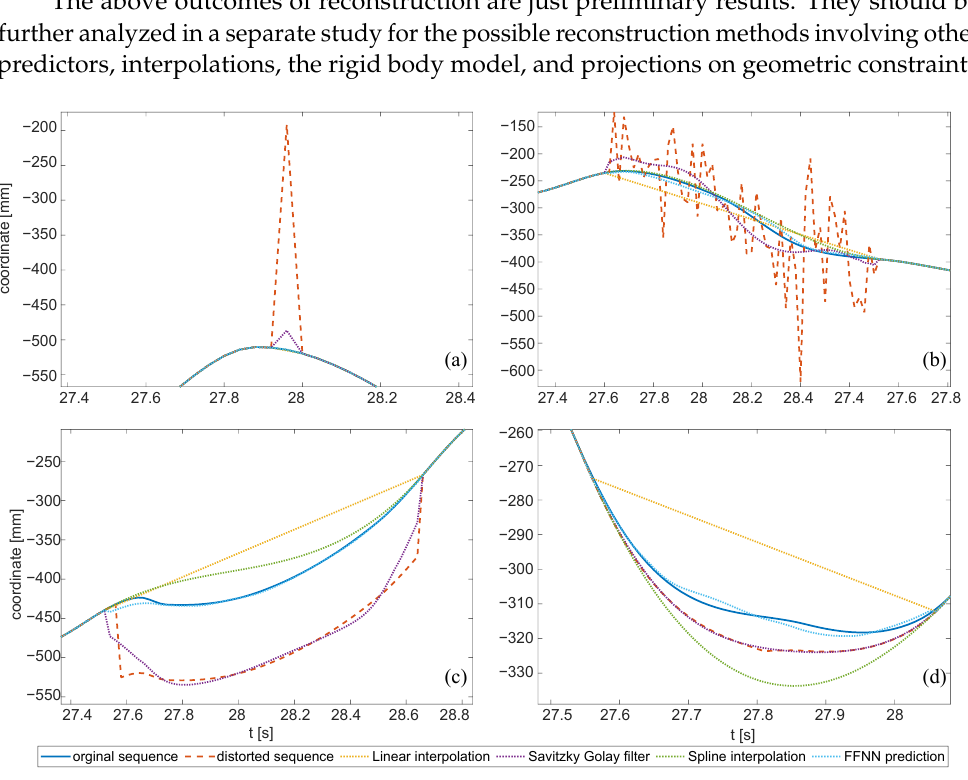
Figure 17. Artifacts and the removal with methods tested in E3: ( a ) single peaks, ( b ) heavy noise, ( c ) step change, ( d ) slow change. Please mind the various scales in the